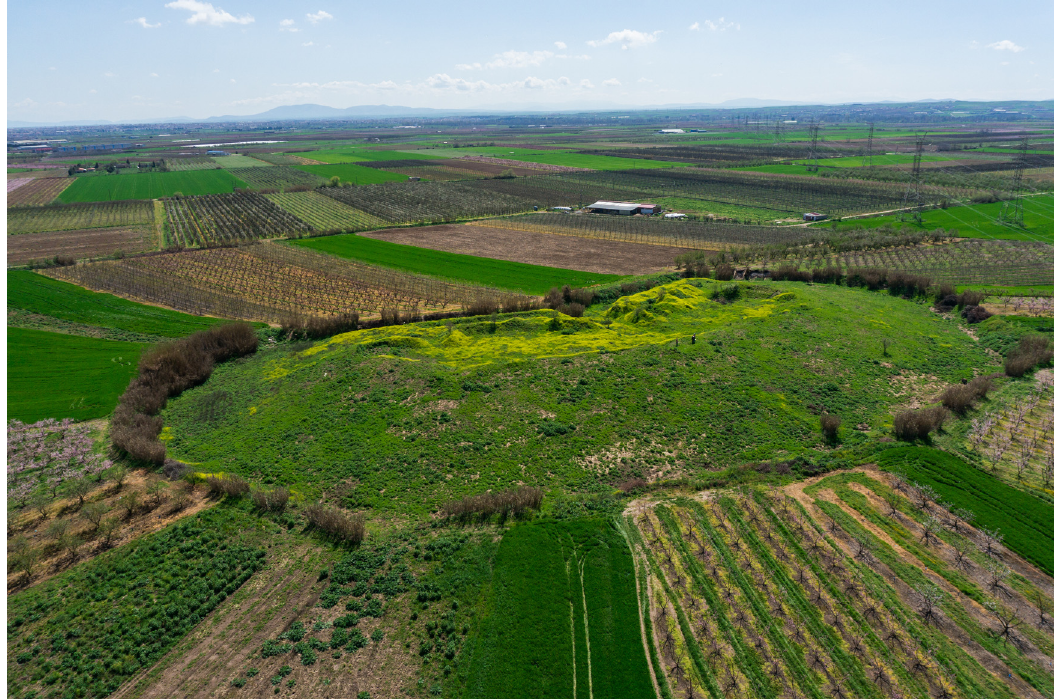
Figure 5: The tell of Otzaki and surrounding landscape, aerial photograph ( Copyright: Ephorate of Antiquities of Larissa ) .